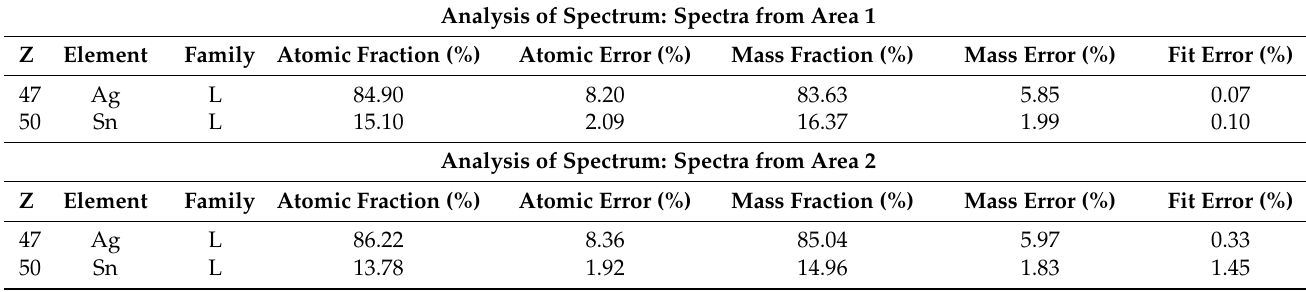
Table 2. Quantitative analysis of areas 1 and 2.